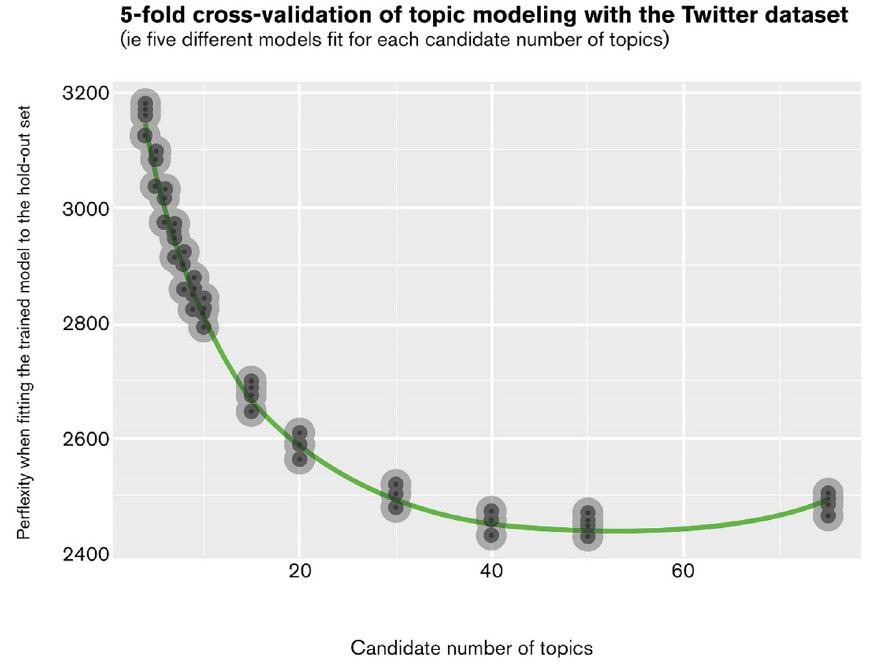
Figure 3. Perplexity in cross-validation.